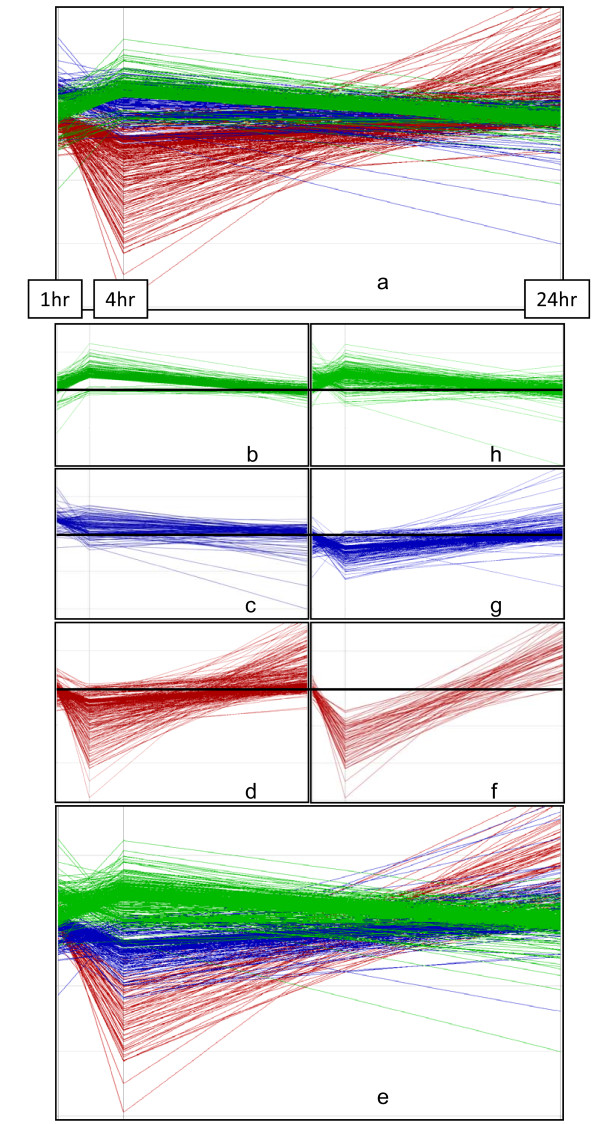
Kmeans clustering of medium stringency microarray dataset. 2a-d Pearson metric, 2e-h Euclidean metric. Each color represents the results of a discrete K-means cluster. Each line in the cluster represents the expression of a member gene over the time course. Bar across figures b-d and f-h indicates no change from control animal gene expression.